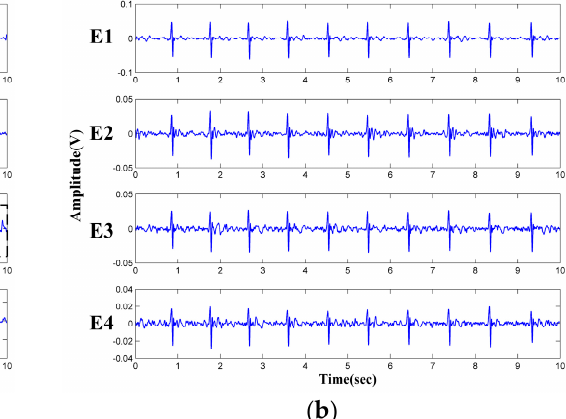
Table 1. QRS peak amplitude